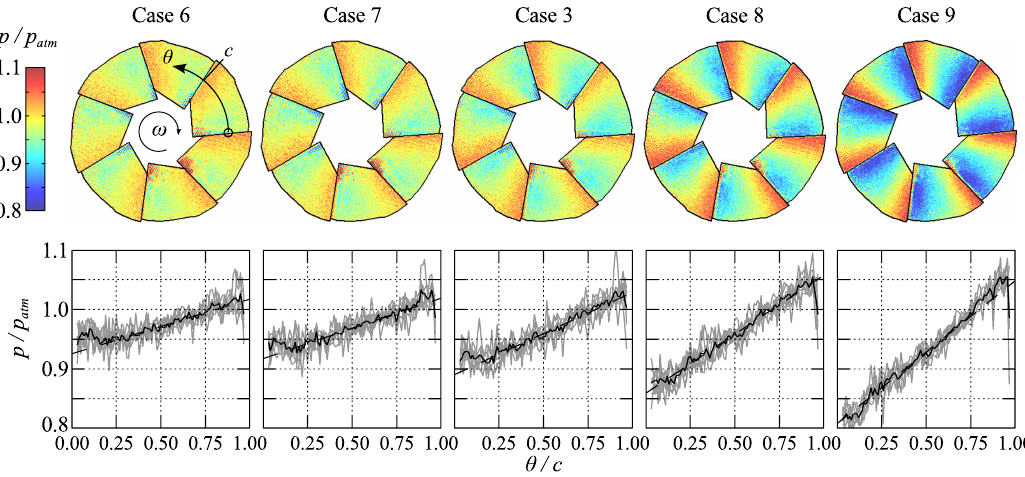
Figure 11. Pressure distribution on the impeller blades (upper row of figure) from scanning measurements for cases 6, 7, 3, 8 and 9, i.e. , with increasing rotational speed. The lower row of the figure shows the pressure along the chord, defined in case 6 as c = 2 π /7, of the blade at half the blade radius, grey lines show the distribution from the seven individual blades, black line their average.